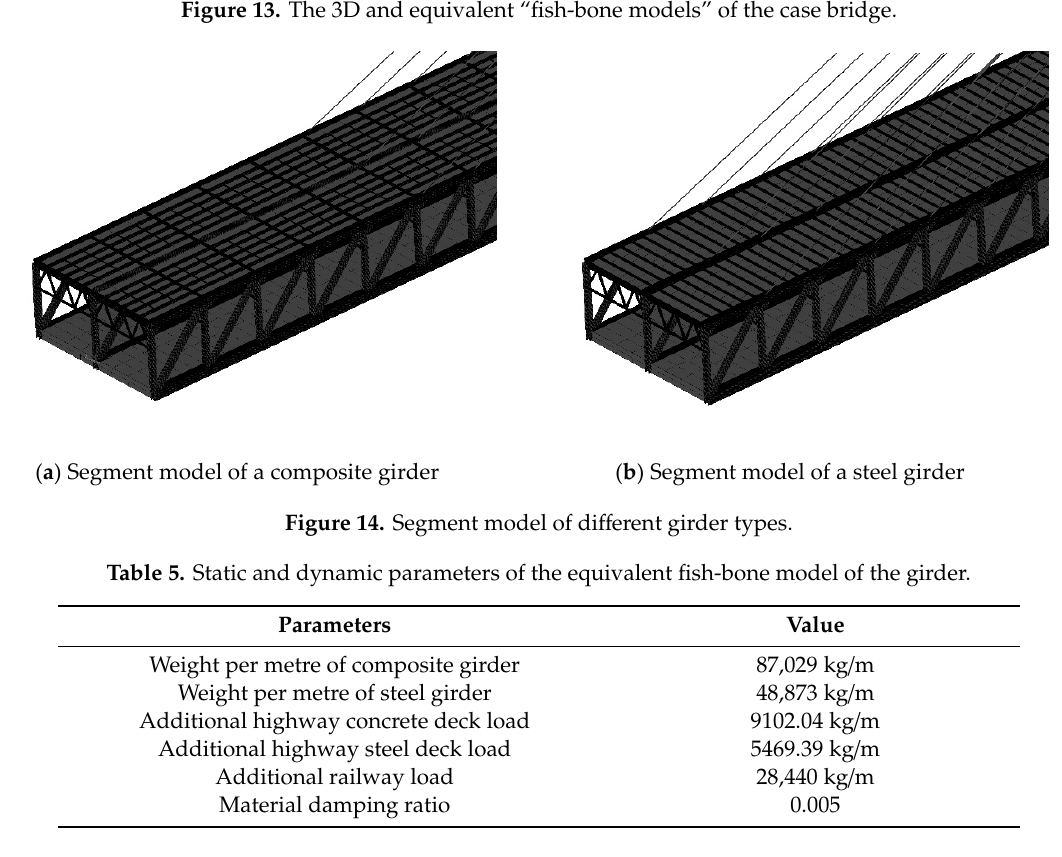
Table 6. Inertia moment of the fish-bone model girder (m 4 ).